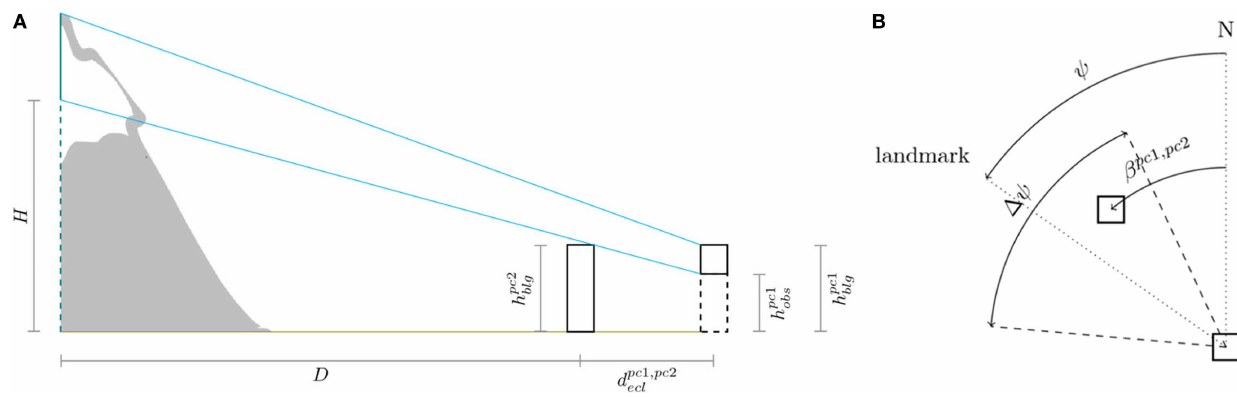
FIGURE 2 | Views of a planning site to illustrate considered heights, distances and angles for the calculation of the LVF. (A) Side view. (B) Top view.